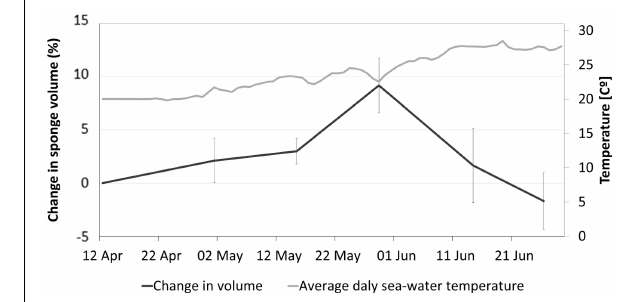
FIGURE 8 | Percentage change in sponge volume throughout the experiment for A. oroides specimens transplanted to a shallow site n = 6.